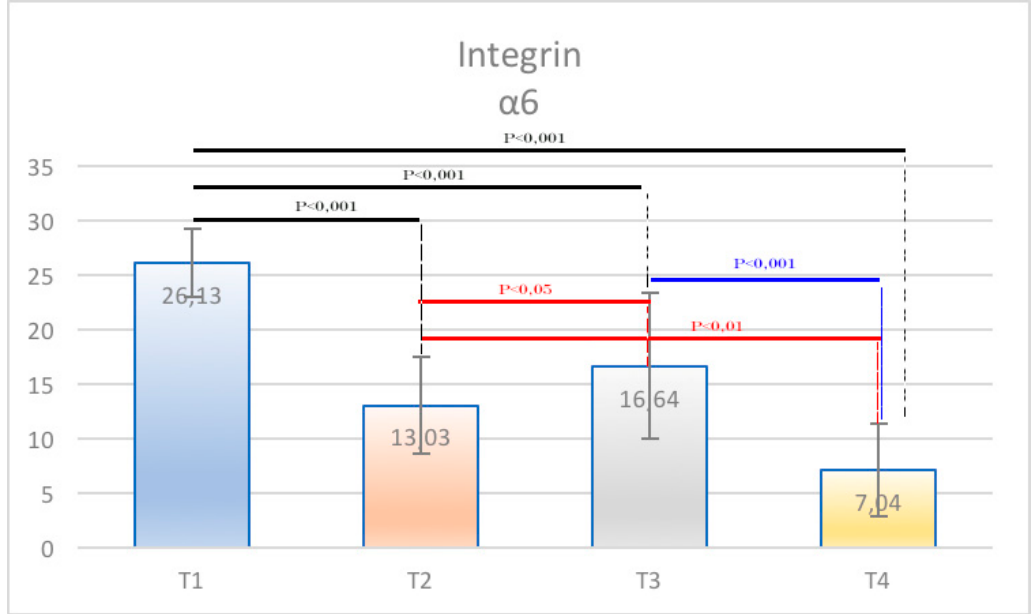
Figure 3. Graphical representation of α 6 integrins in different groups. Statistically significant differences between groups were found.